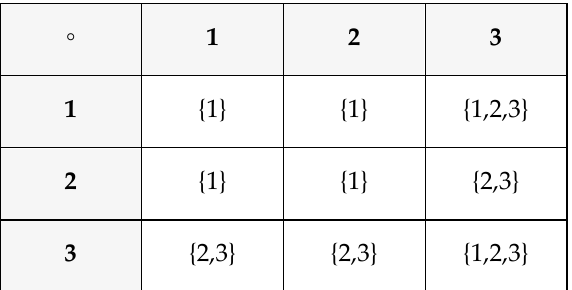
Table 3. Left almost-hypergroup.